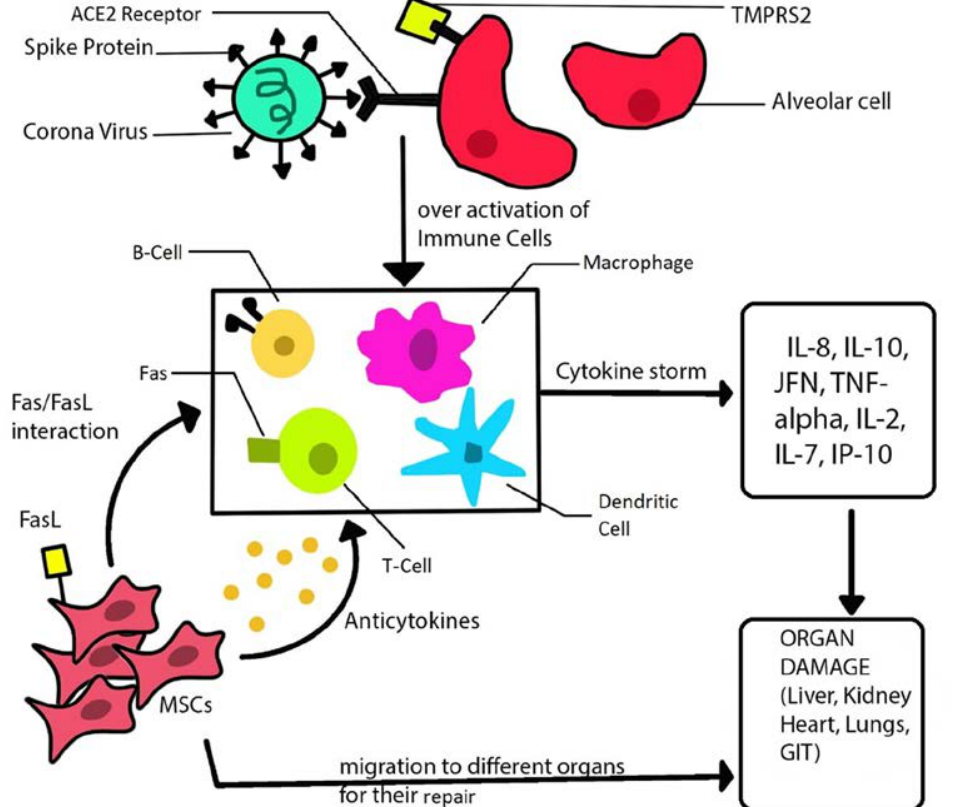
Fig. 1. MSCs (extracted from human umbilical cord blood) transferred intravenously triggering immune response which activate the immune cells. Thus MSCs releases EVs and Anti-cytokines which migrate to damaged organs and also overcome the hyper-activation of immune cells and